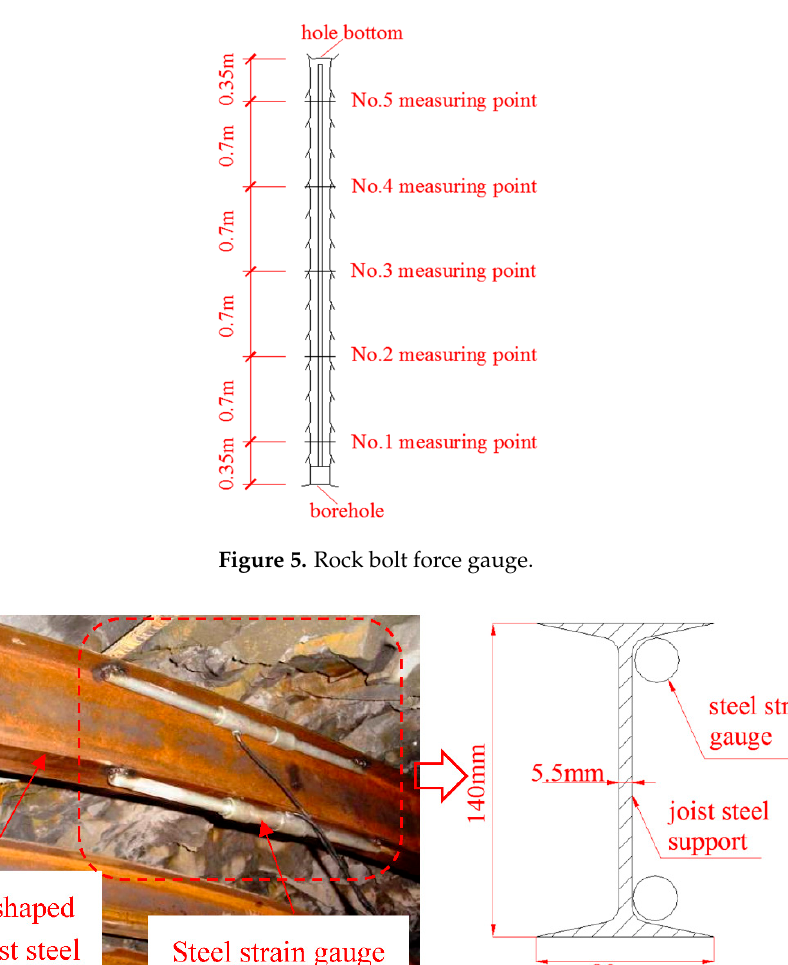
Figure 6. Layouts of the steel strain gauges.